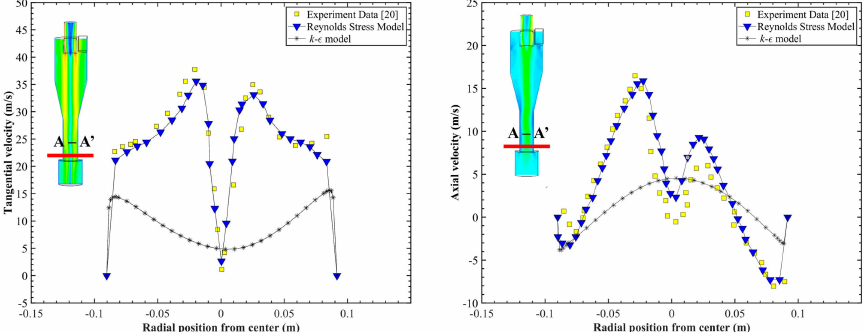
Figure 6. Comparison results of the velocity distribution experiment and the prediction results according to the turbulence